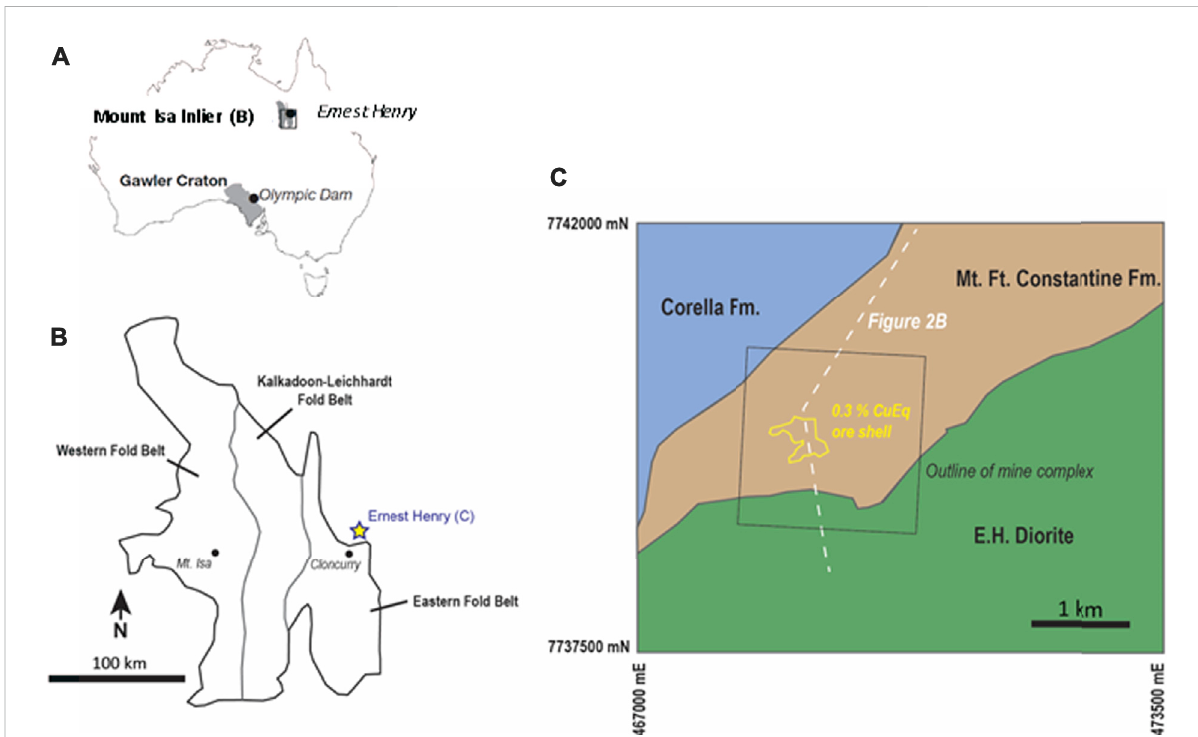
FIGURE 1 (A) Map of Australia, showing the location of the Mount Isa Inlier and Ernest Henry. Also shown is the Gawler Craton and Olympic Dam. After Williams et al. (2005). (B) Schematic of the Mount Isa Inlier, showing the three major tectonostratigraphic domains (Western Fold Belt, Kalkadoon- Leichhardt Fold Belt, and Eastern Fold Belt). Ernest Henry is situated NE of Cloncurry. (C) Generalized geologic map of the Proterozoic rock units in the Ernest Henry area, illustrating the location and extent of the mine complex. Ernest Henry is hosted within correlatives to the Paleoproterozoic Mount Fort Constantine Volcanics, a sequence of felsic-intermediate metavolcanic rocks intercalated with minor carbonate-rich metasedimentary rock units. The deposit is underlain by the younger but still Paleoproterozoic Corella Formation to the NW, a